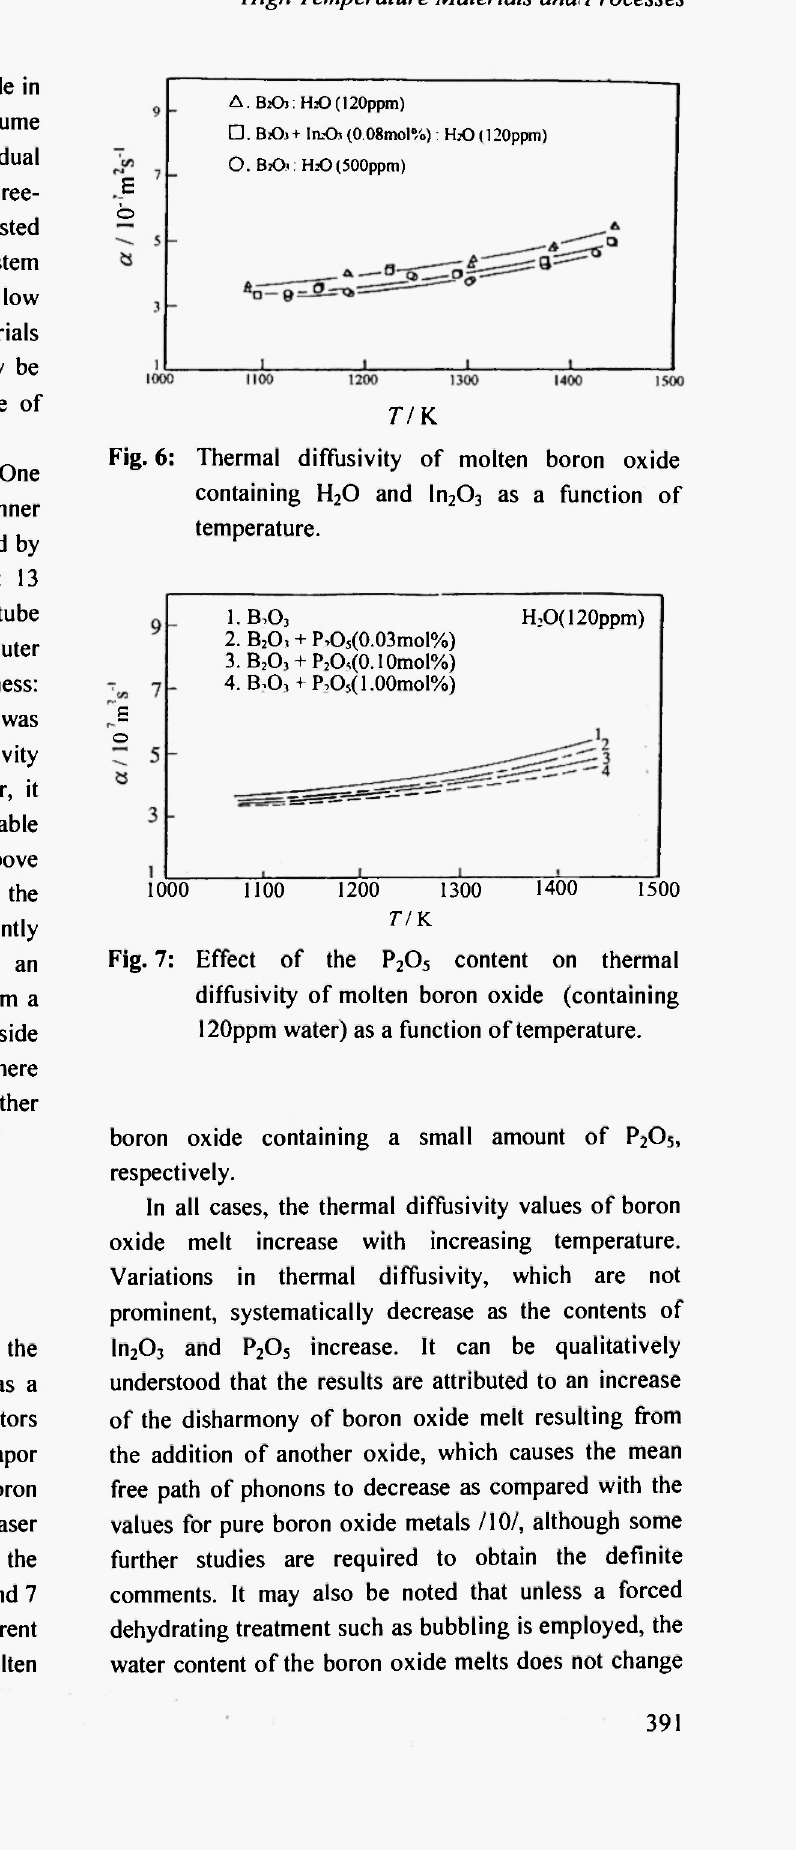
Fig. 6: Thermal diffusivity of molten boron oxide containing H 2 0 and ln 2 0 3 as a function of temperature.